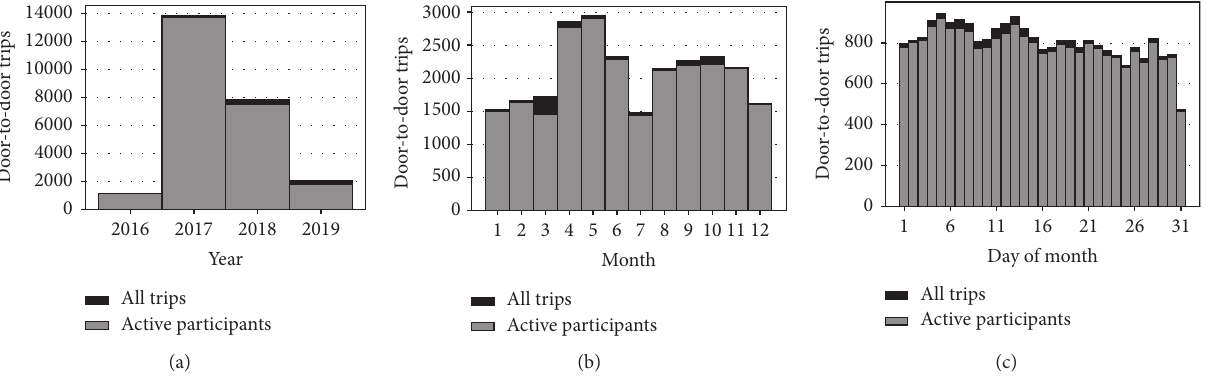
Figure 3: Door-to-door trips observed during the data collection period, by (a) year, (b) month, and (c) day of month.